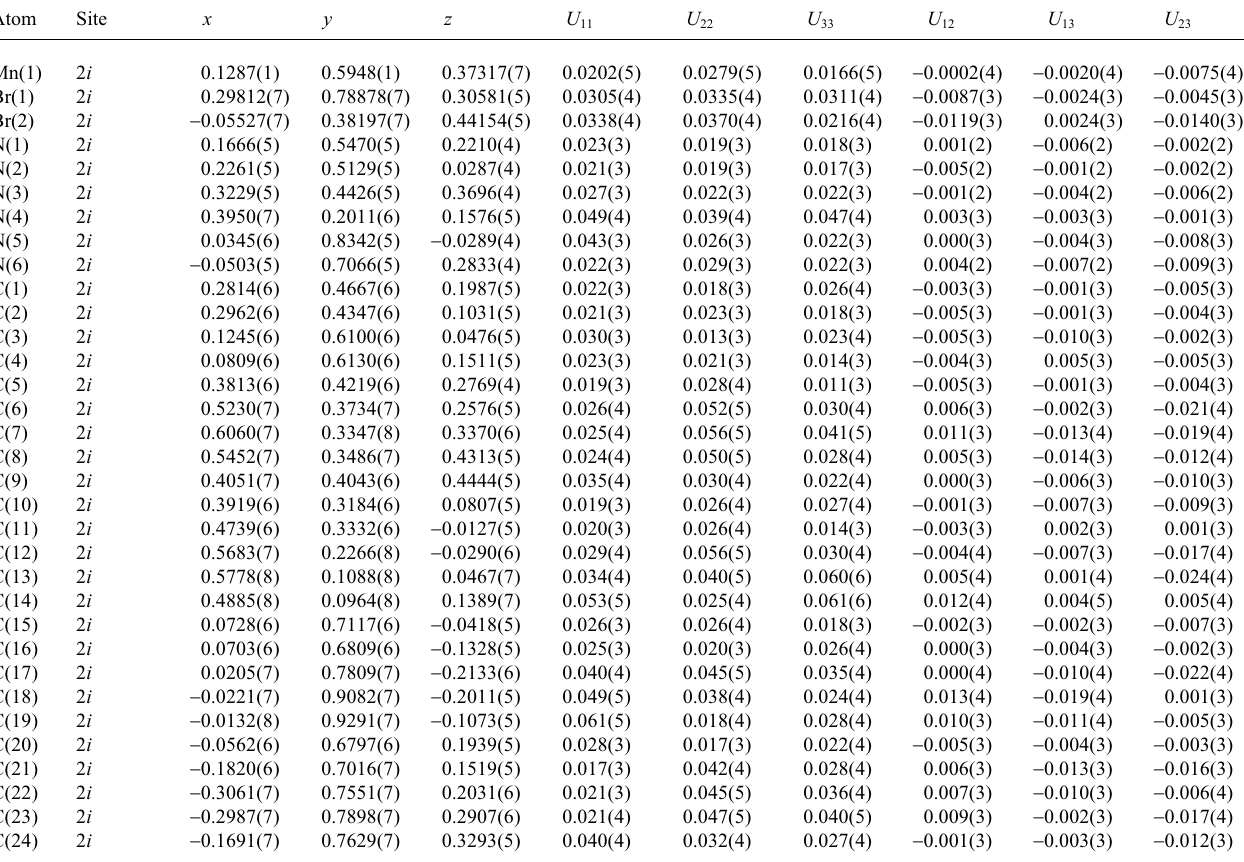
Table 3. Atomic coordinates and displacement parameters (in Å 2 ).